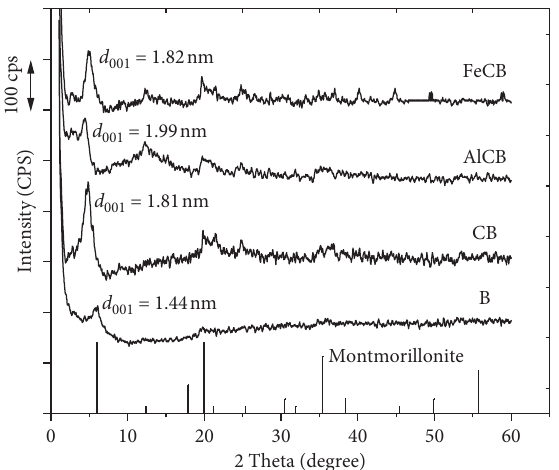
Figure 1: XRD patterns of B (bentonite), CB (CTAB-bentonite), AlCB (Al-CTAB bentonite), and FeCB (Al-CTAB